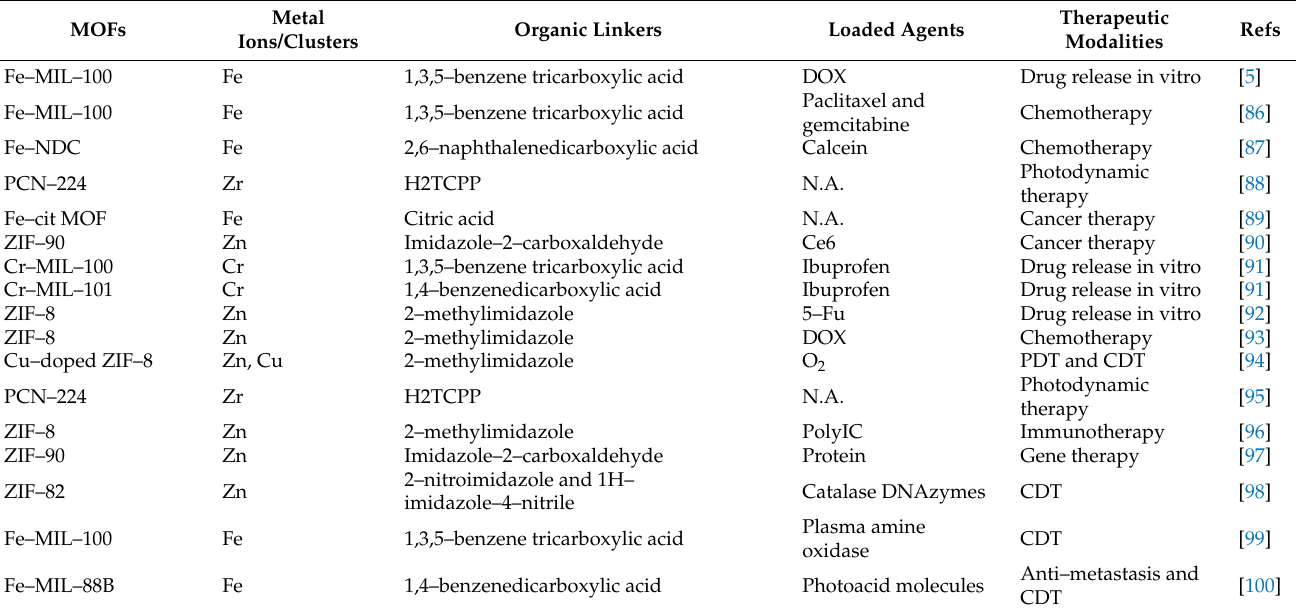
Table 1. Typical examples of MOF–based nanocarriers for cancer